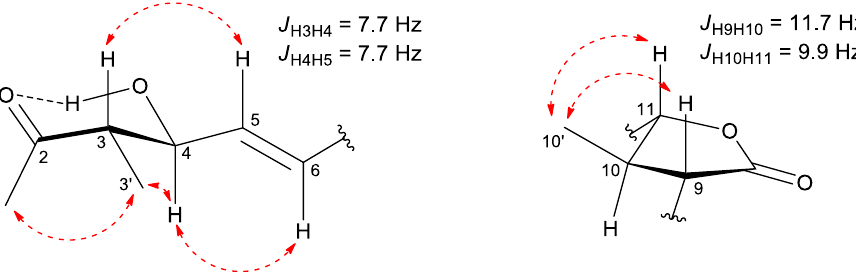
Figure 2. Key COSY and TOCSY correlations (bold bonds) determining the different spin systems of curvicollide D. Key HMBC correlations (blue arrows, H to C) connecting the different spin sys- tems and rendering the connectivity of curvicollide D.